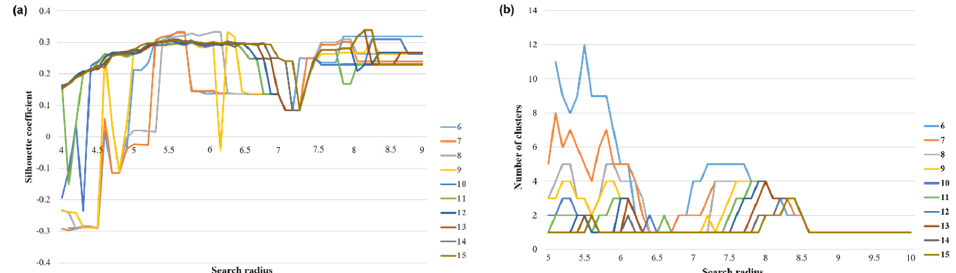
Figure 8. Determination of the clustering threshold value of the departure time series on weekdays: ( a ) the contour coefficients of the clustering results under different threshold combinations and ( b ) the number of clusters under different threshold combinations.